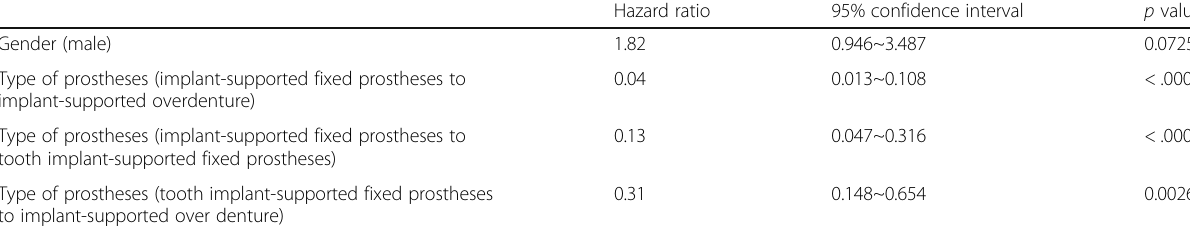
Table 7 Cox regression analyses for cumulative survival rate of complication-free prostheses